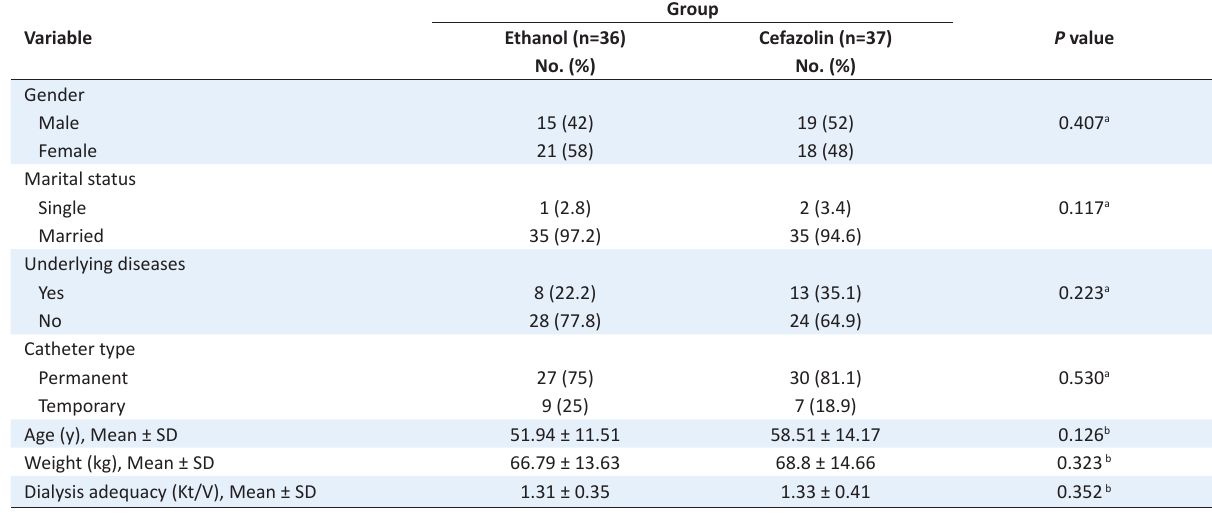
Table 1. Comparison of demographic characteristics including age, weight, gender, underlying disease, marital status, catheter type, and dialysis adequacy between two groups of ethanol and cefazolin